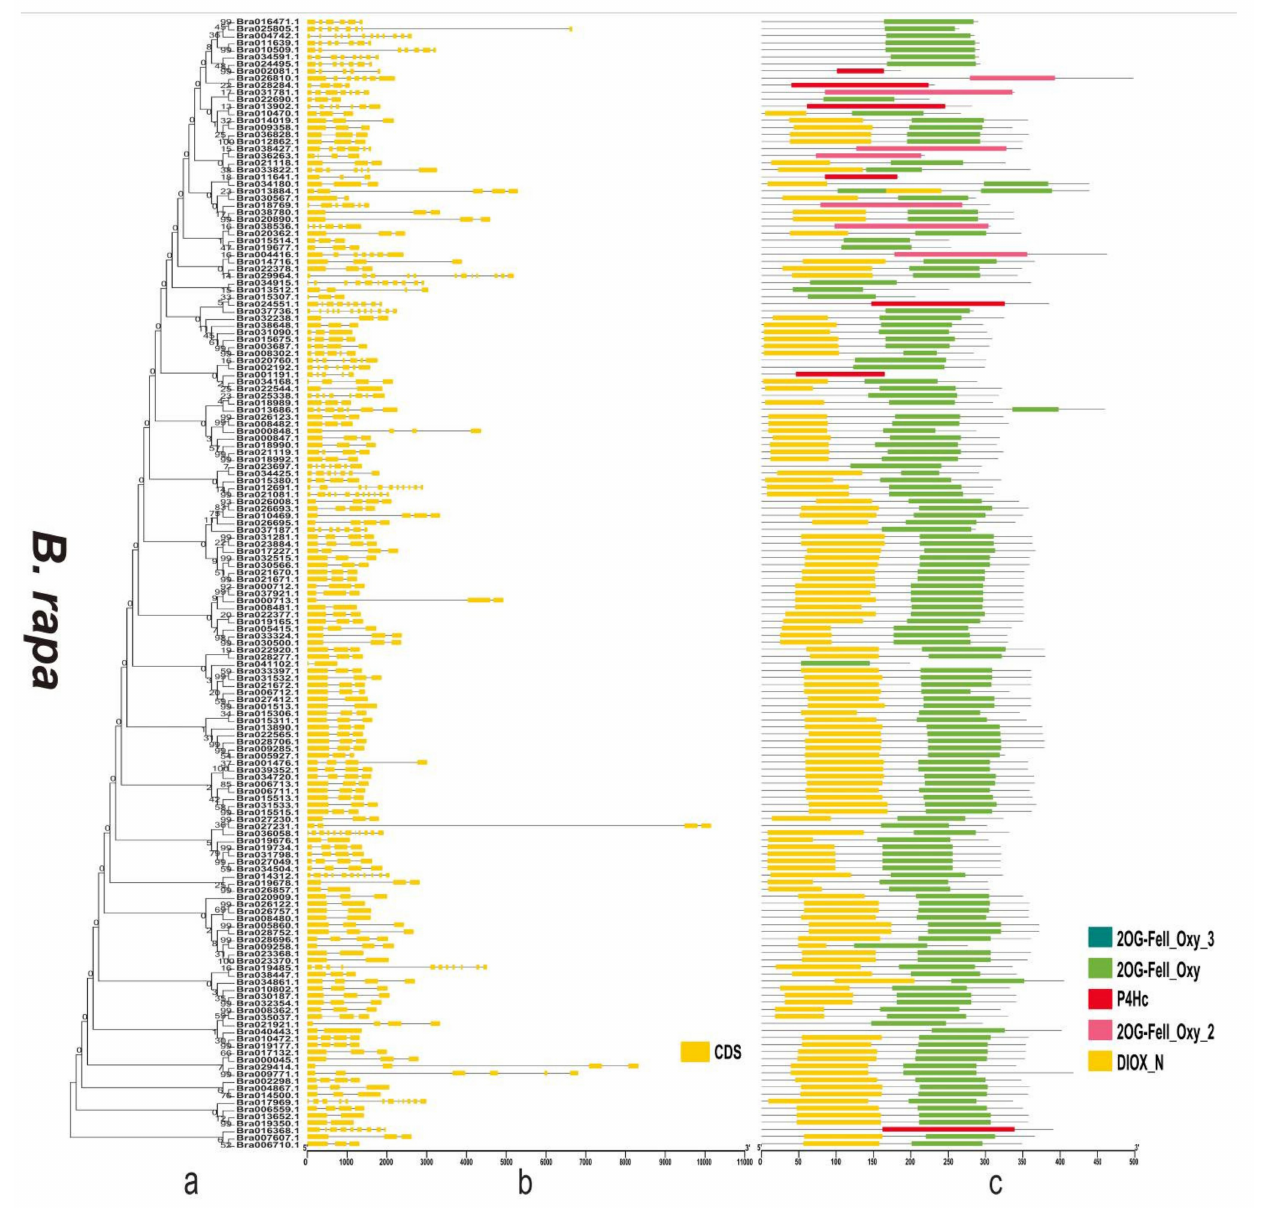
Figure 7. Phylogenetic relationships, gene structure, and domains in the 2OGD genes from B. rapa . ( a ) The phylogenetic tree was constructed based on the full-length protein sequences of 2OGDsusing MEGA-X software. ( b ) Exon-intron structure of the 2OGD genes. Green boxes indicate untranslated 5 (cid:48) - and 3 (cid:48) - regions; yellow boxes indicate exons; and black lines indicate introns. ( c ) The domain composition of the 2OGD proteins. The domains DIOX_N and 2OG-FeII_Oxy. Some genes that only have 2OG-FeII_Oxy_2, 2OG-FeII_Oxy_3, or P4Hc are displayed in different coloured boxes. The length of proteins can be estimated using the scale at the